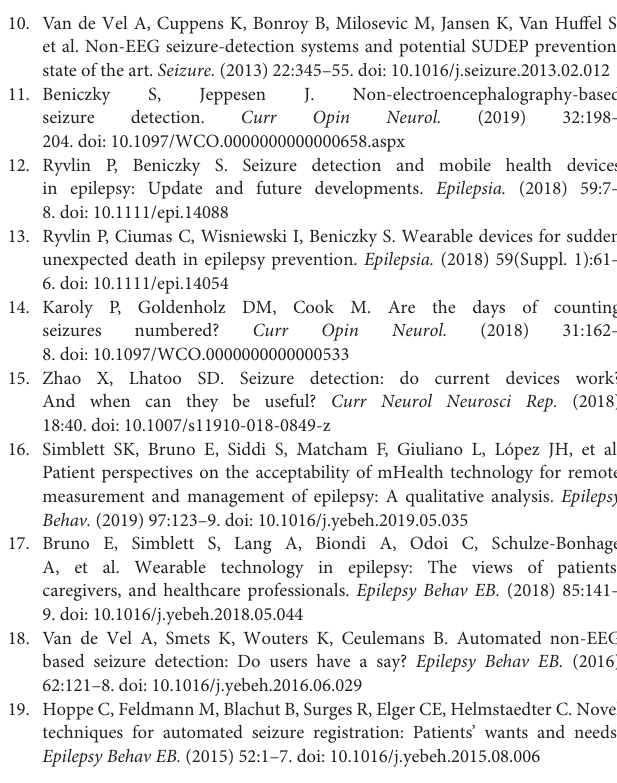
Supplementary Figure 1 | Timeline of the data collection at each clinical site. Supplementary Figure 2 | Statistics on rest periods. (A) Distribution of the duration of the detected rest periods. (B) Distribution of the individual number of rest periods per days of